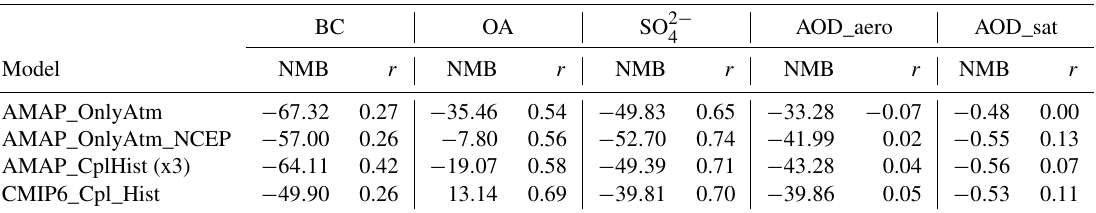
Table 2. Annual mean normalized mean bias (NMB: %) and correlation coefficients ( r ) for the recent past simulations in the GISS-E2.1 model ensemble during 1995–2014 for BC, OA, SO 2 − , and 2008/09–2014 for AOD550 from AERONET and satellites. 4